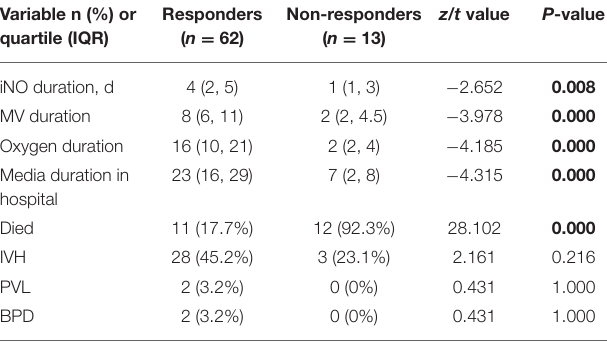
TABLE 4 | Outcomes of the included